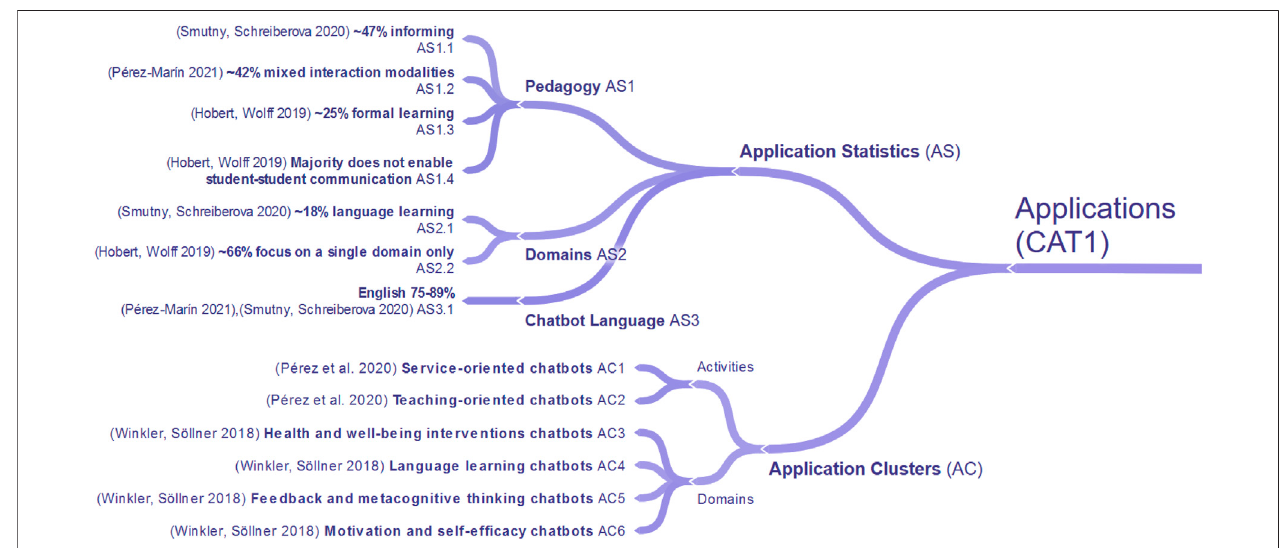
FIGURE 1 | Applications of chatbots in related literature reviews